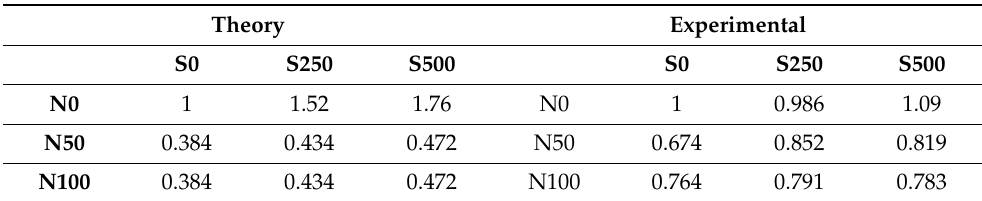
Table 3. Theoretical and experimental E / E 0 value for various neutralization degrees and salt